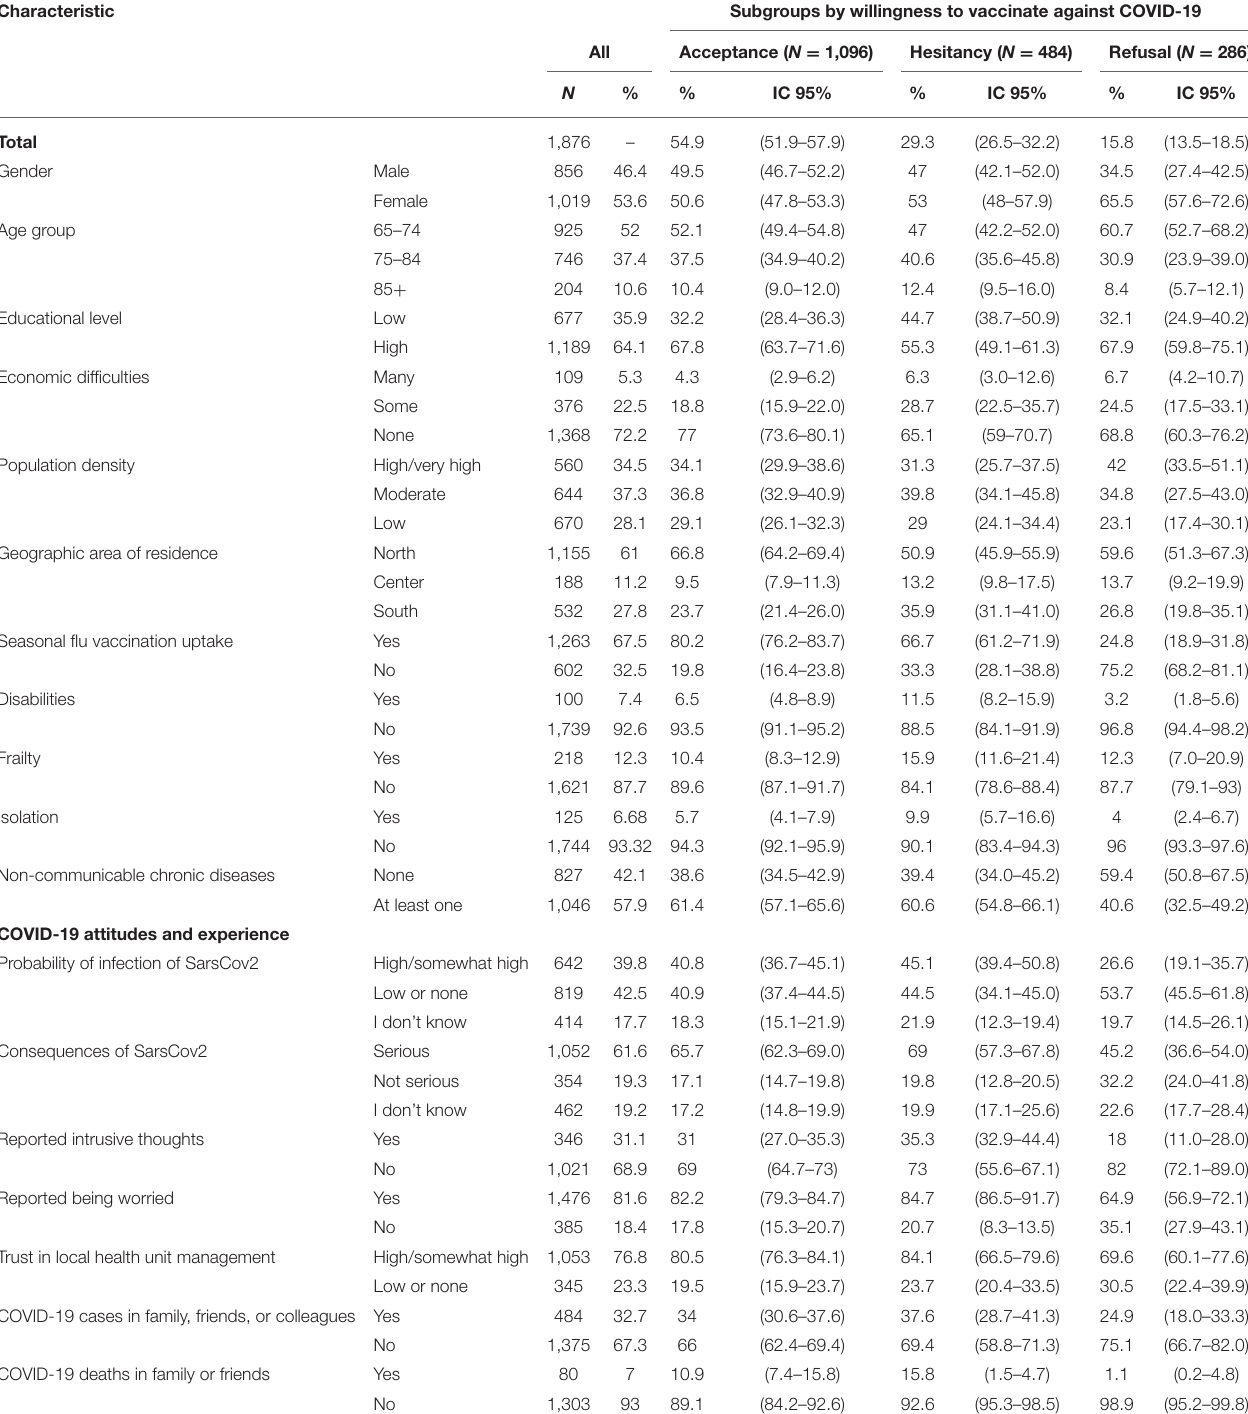
TABLE 1 | Characteristics of Italian elderly overall and by willingness to vaccinate against COVID-19, Passi d’Argento, August-December